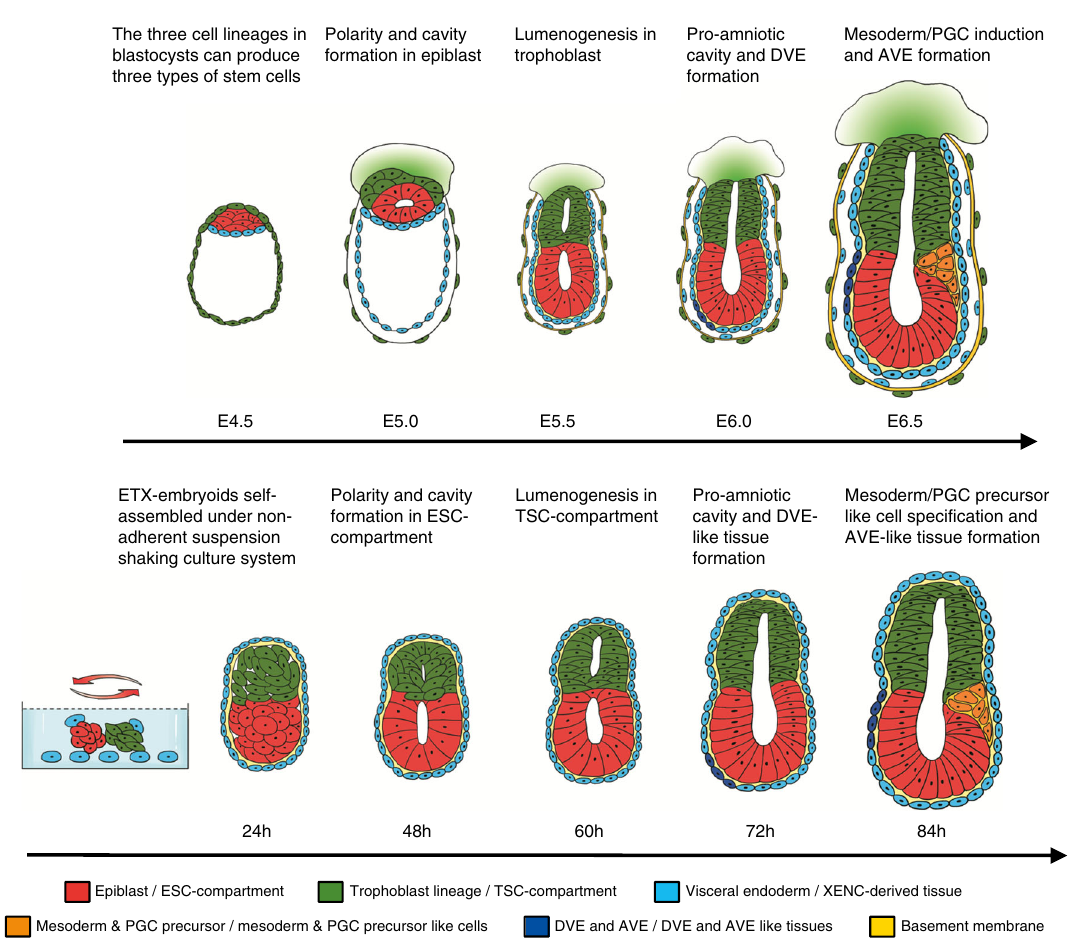
Fig. 8 Comparison of the developmental characteristics of a wild-type conceptus to that of ETX-embryoids. The ETX-embryoids, with spatial composition resembling that of post-implantation embryos, can be self-assembled by aggregation of the three types of blastocyst-derived stem cells under nonadherent-suspension-shaking culture condition. When allowed to develop in vitro, the ETX-embryoids can be seen as a model to mimic the events, such as polarity, lumenogenesis, DVE and AVE formation, mesoderm and PGC induction, which occur in wild-type embryos. However, the ETX-embryoids lack the outer layer of the trophoblast and parietal endoderm together with the basement membrane between them, which surround the entire conceptus and protect their development in